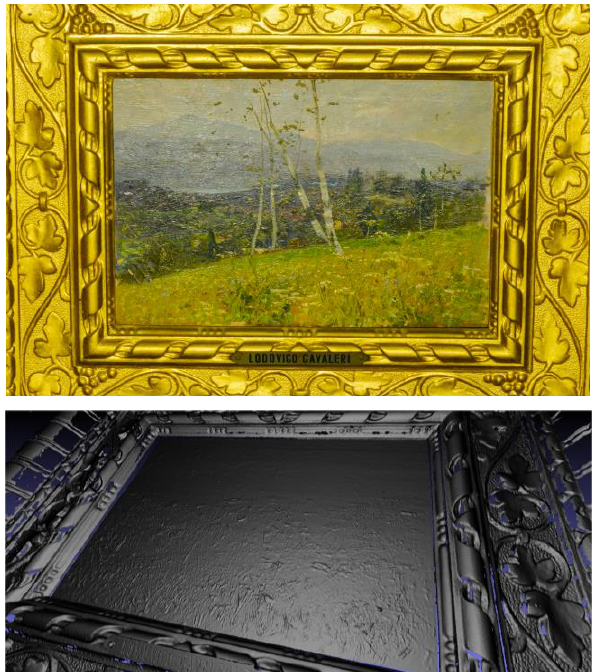
Figure 7. Oil on canvas by Ludovico Cavalieri: an image of the artwork (above) and the structured light system’s 3D model visualized in shaded mode (below). The brush strokes are clearly visible thanks to the sub- millimetre geometric resolution of the digitization.